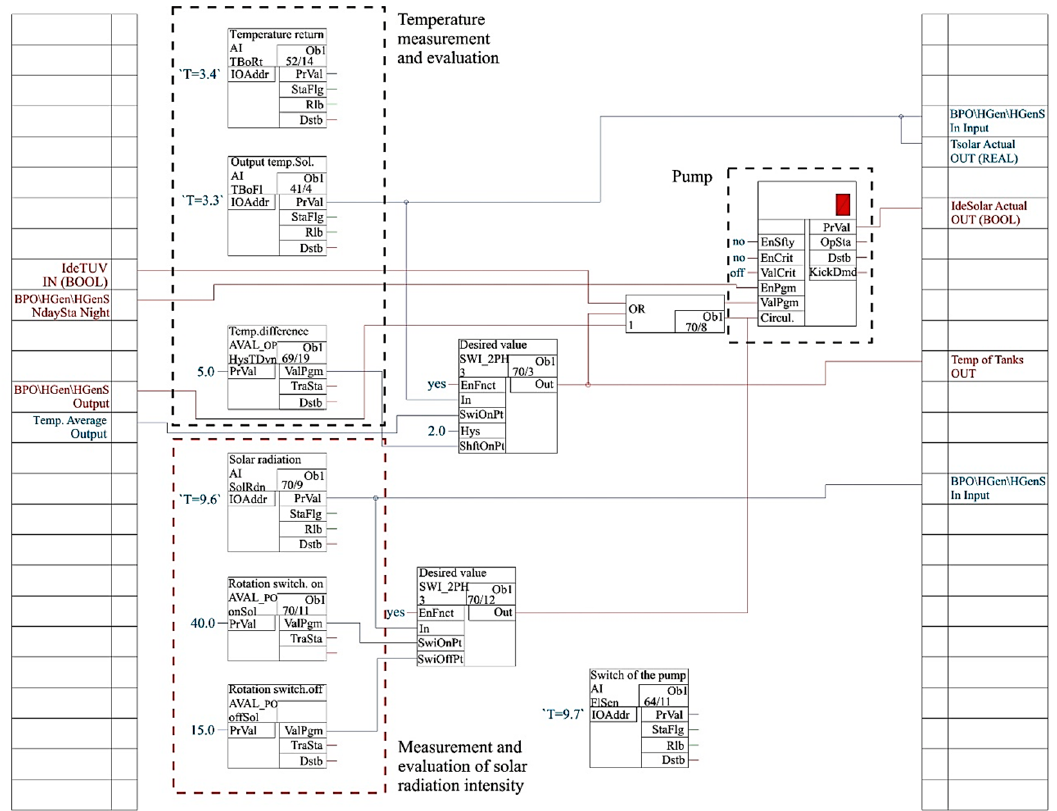
Figure 8. Diagram of the pump system control.